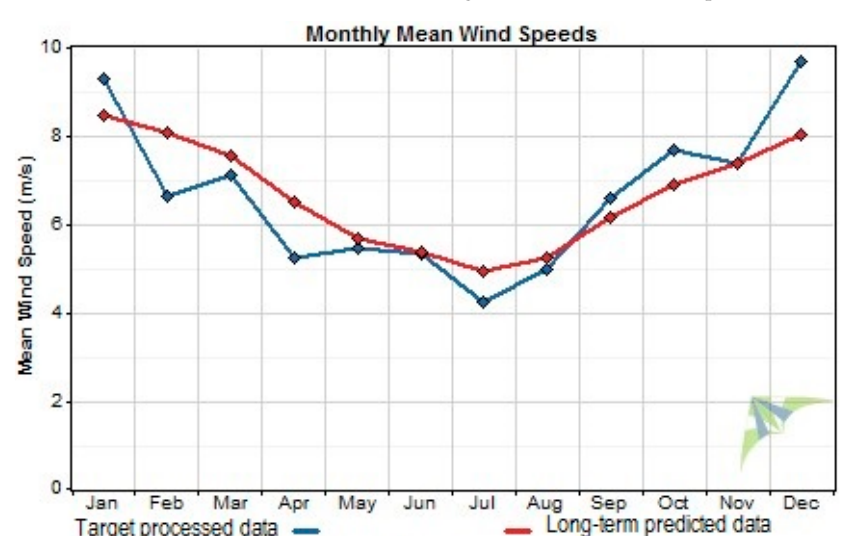
Figure 11. Comparison of the wind farm’s monthly mean wind speeds and the long-term predicted wind speeds. Table 5. Comparison of the target and long-term predicted data.